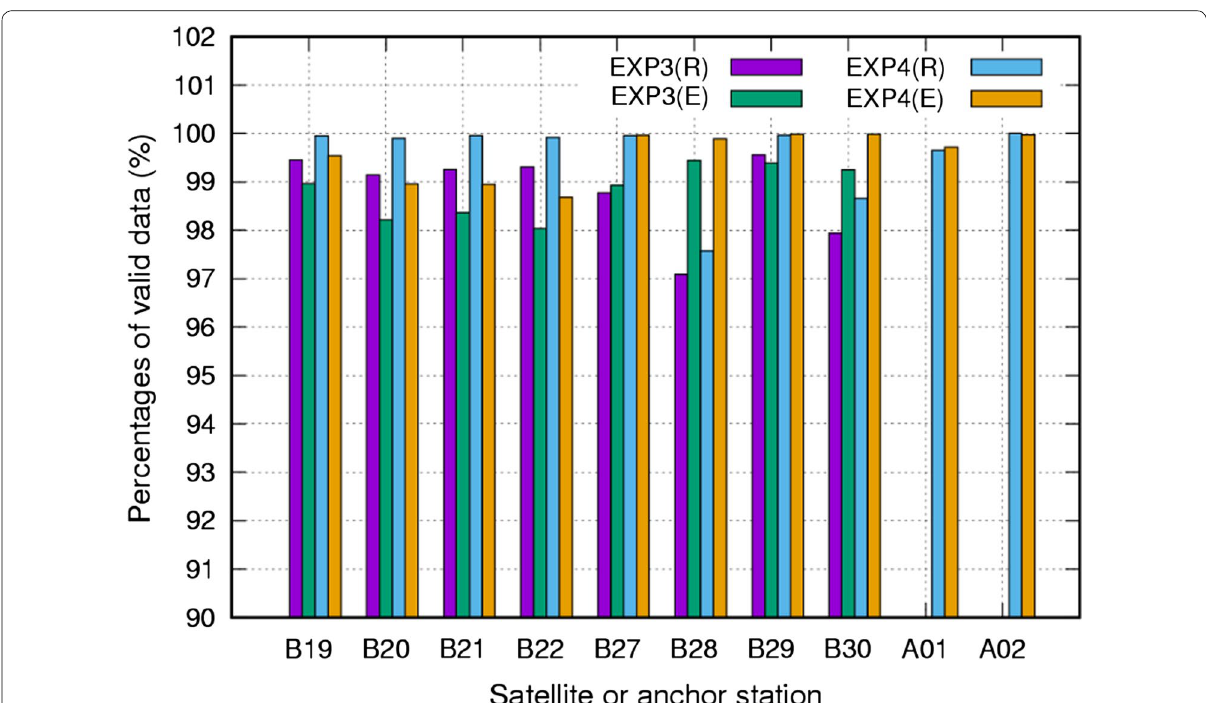
Fig. 6 The percentage of valid one-way Ka-pseudorange data in EXP3 and EXP4 for each satellite or anchor station. R and E in the legend represent reception and transmission, respectively